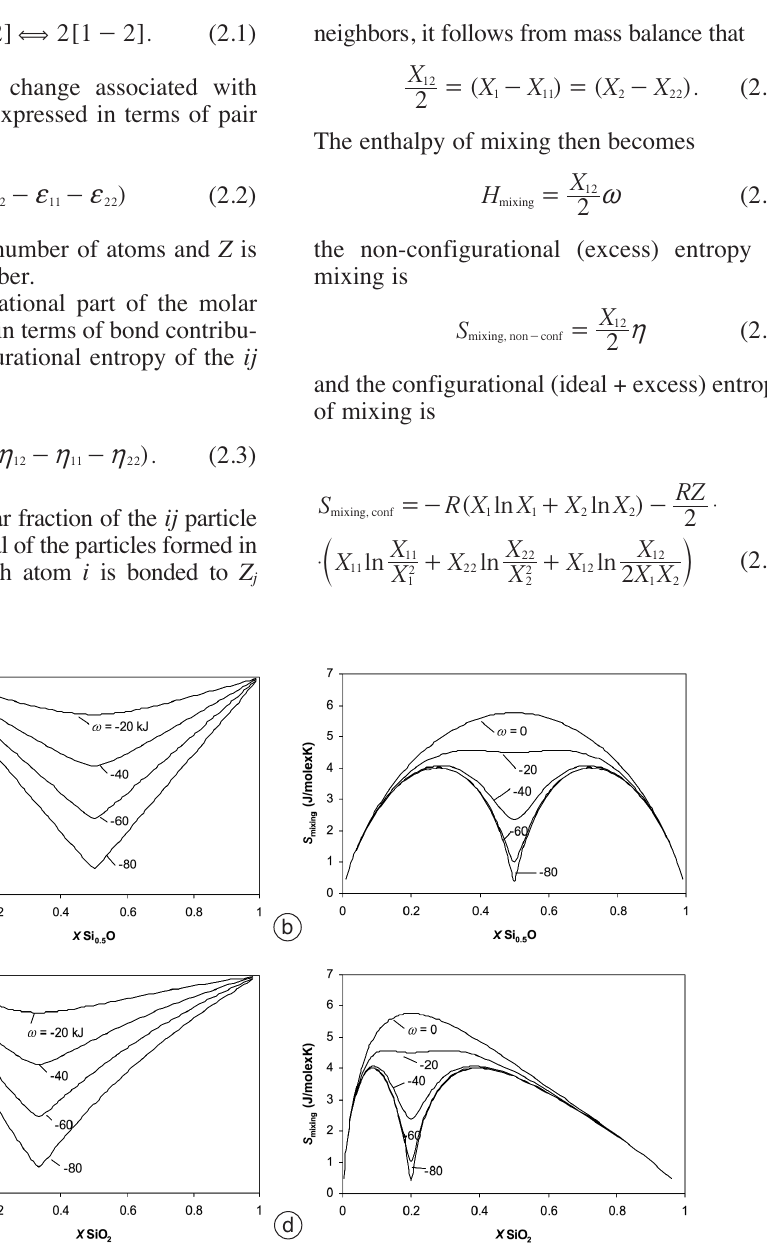
c Fig. 1a-d. Integral enthalpy of mixing and integral entropy of mixing of quasi -chemical model for different values of interaction parameter ω along MO-Si 0.5 O 2 join ((a) and (b), respectively). Below: if usual molar nota- tion ( i.e. , component SiO 2 instead of Si 0.5 O) is adopted and parameter ω is kept unvaried, symmetricity about in- termediate composition is lost ((c) and (d) respectively).